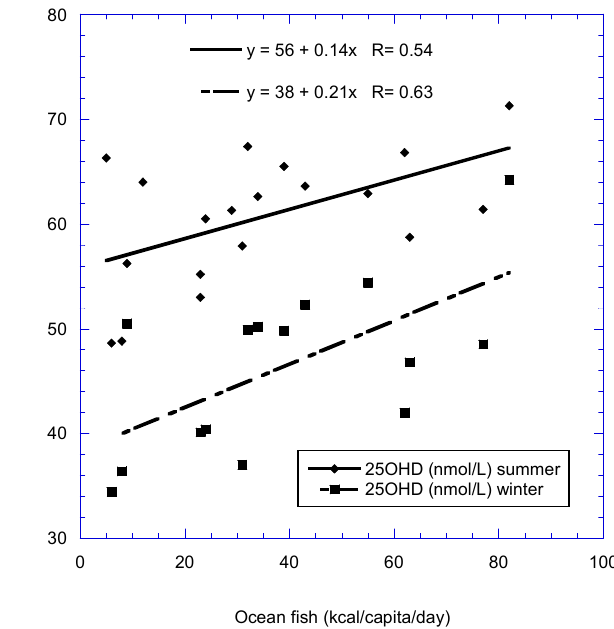
Figure 2. Plot of 25(OH)D concentration vs. latitude for the 19-country European postmenopausal women’s study [22]. Nutrients 2019 , 11 , x FOR PEER REVIEW